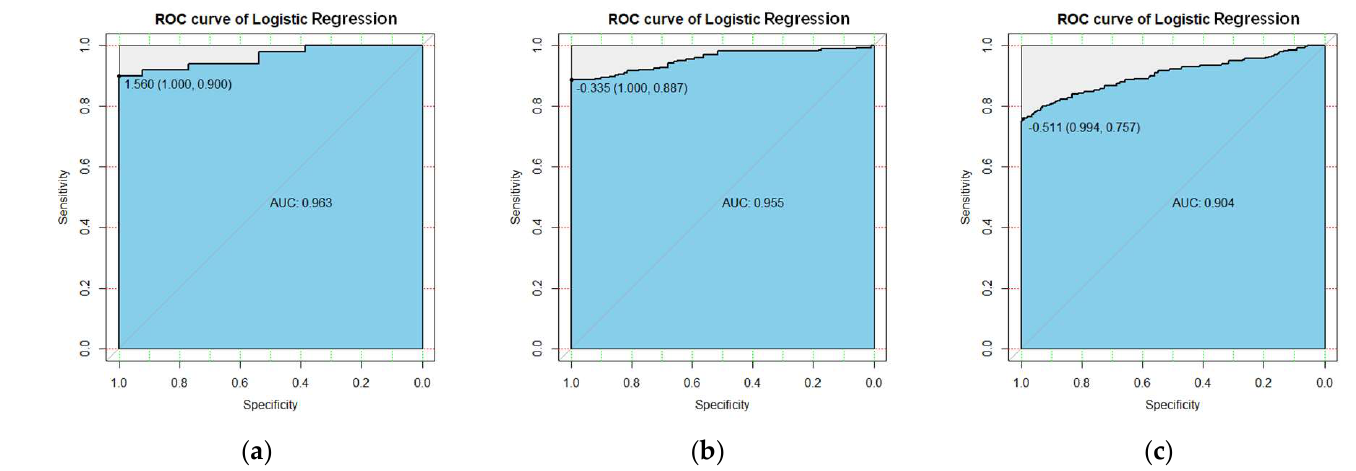
Figure 4. The ROC curve of the LR after segmentation. ( a ) Cluster I; ( b ) Cluster II; ( c ) Cluster III.